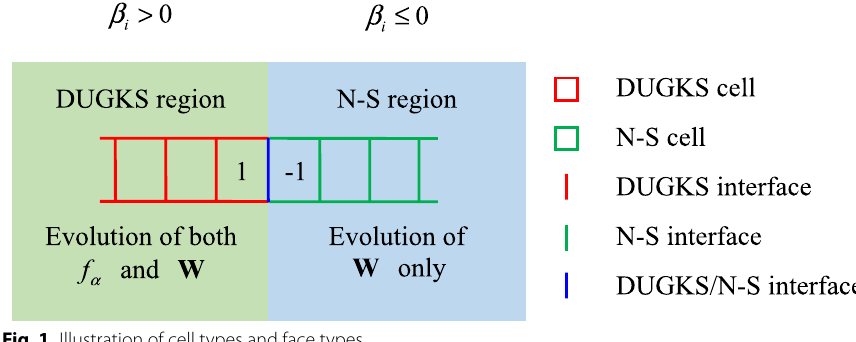
Fig. 1 Illustration of cell types and face